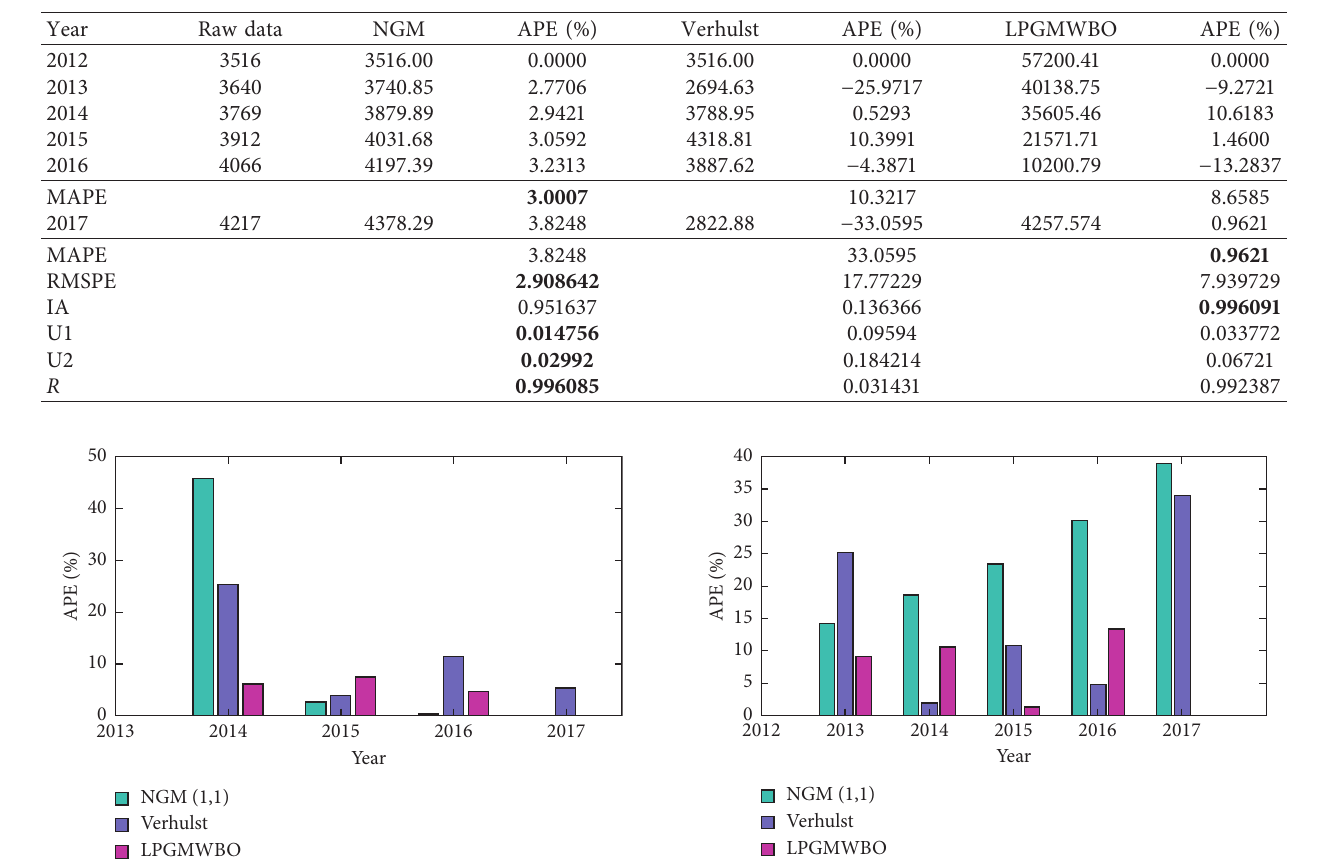
Table 9: Fitting metrics of models for validation of Sichuan data.